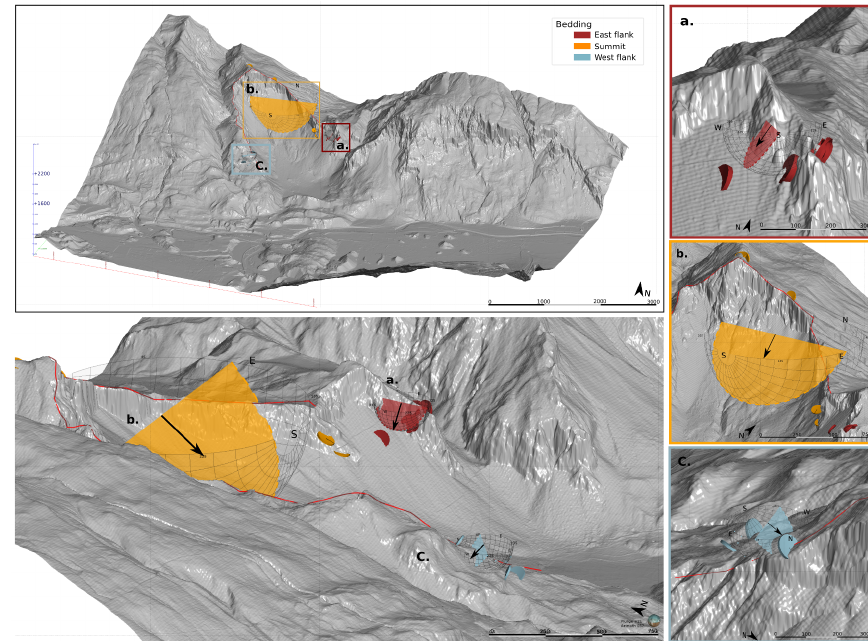
Figure 7. Five different views of the 3D model of the Tamins rockslide: the upper left panel gives a global view of the rockslide and the lower left panel a detailed view of the three stereonets with the bedding of the ( a ) east flank, ( b ) summit, and ( c ) west flank. The colour planes are the Fisher mean planes; the black arrows show the plunge of these planes; and the red line outline the scarp of the rockslide (coordinate system: